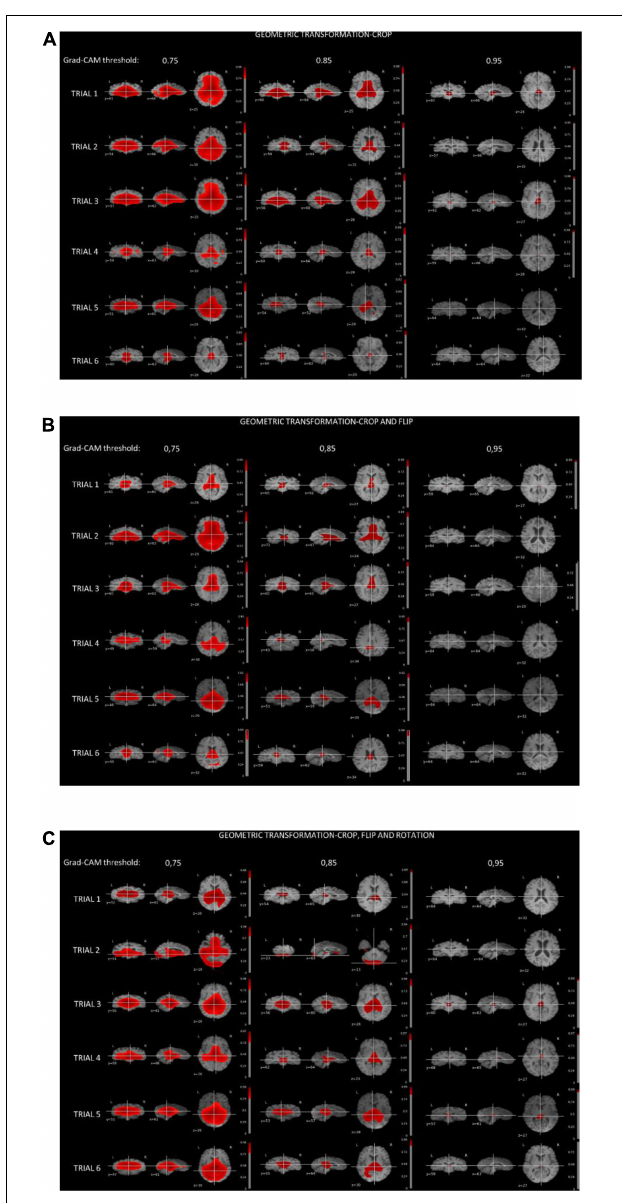
FIGURE 4 | (A) Grad-CAM results of NPSLE patients in the six trials augmented with “crop” (A) , “crop and flip” (B) , and “crop, flip and rotation” (C) . Each row displays thresholded mean grad-CAM maps obtained from the NPSLE test set of one of the trials (1 through 6) overlaid on a T1-weighted dataset. Each column displays a different Grad-CAM threshold: 0.75 (left), 0.85 (middle), and 0.95 (right). Within each column, data are shown in three different orientations: coronal (left), sagittal (middle), and axial